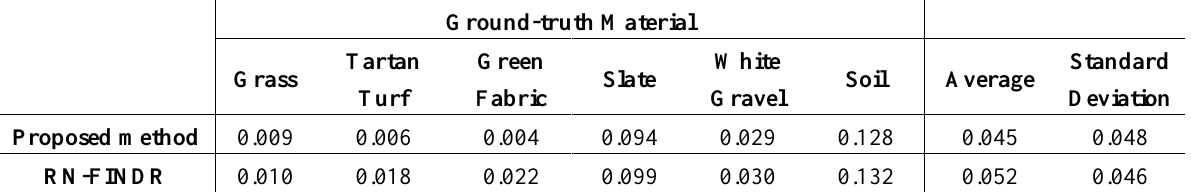
Table 5. RMSE values between ground-truth data and extracted endmembers using the proposed method and the RN-FINDR method on the AISA